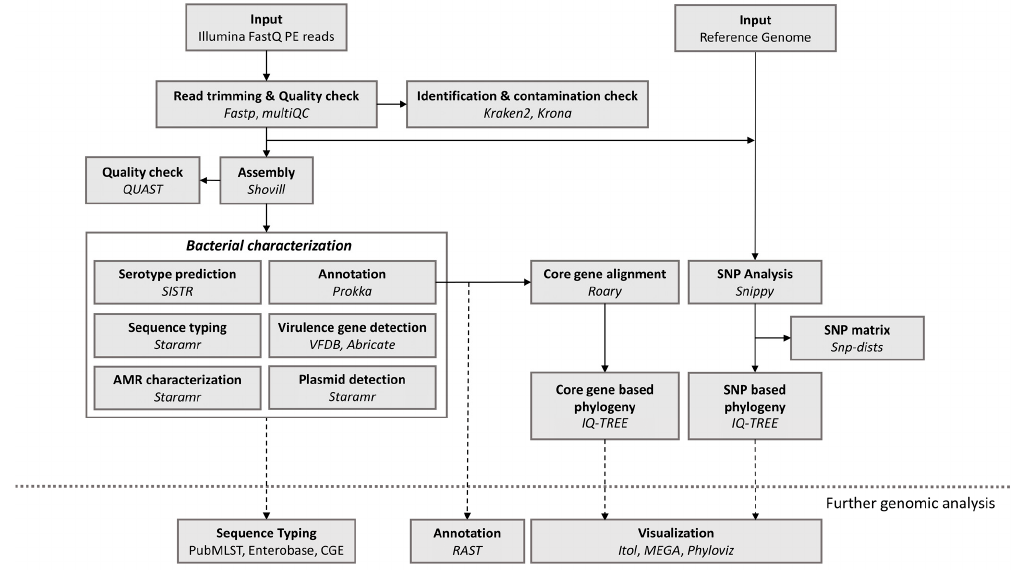
Figure 1. Overview of the bioinformatics workflow. Each box represents a component corresponding to a data analysis (indicated in bold). Software packages employed in each analysis are indicated in italics. Dashed lines indicate further genomic analysis available.